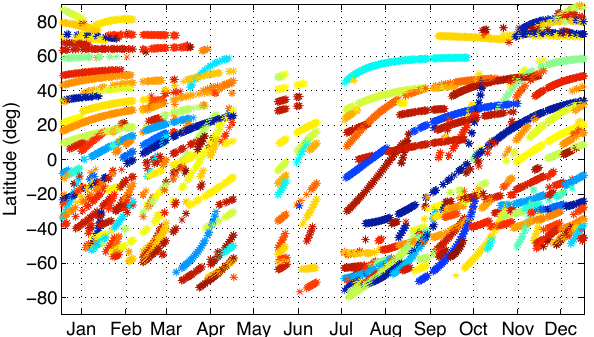
Fig. 4. Latitude coverage of GOMOS night measurements in 2003. The colours indicate the stellar brightness in magnitude. Dark blue indicates bright stars and red dim stars.